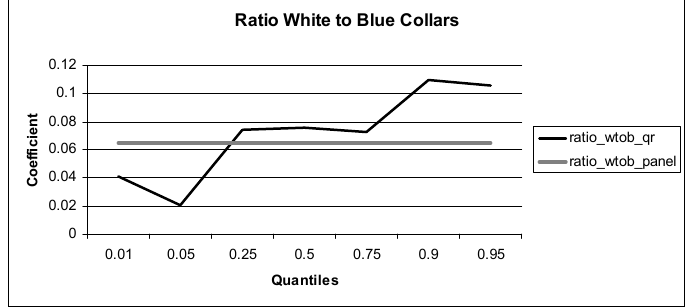
Figure 10 – Quantile Regressions versus Panel Regression estimates for Exporters: Human Capital.